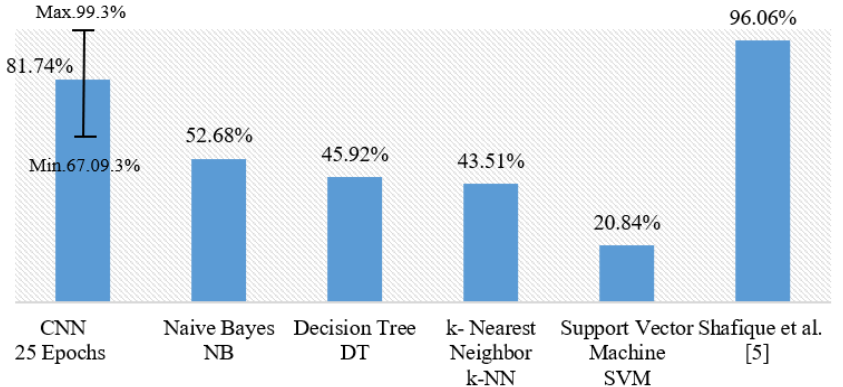
Figure 4. Comparison of our proposals with different machine learning algorithms for the multi-classification of all leukemia subtypes.